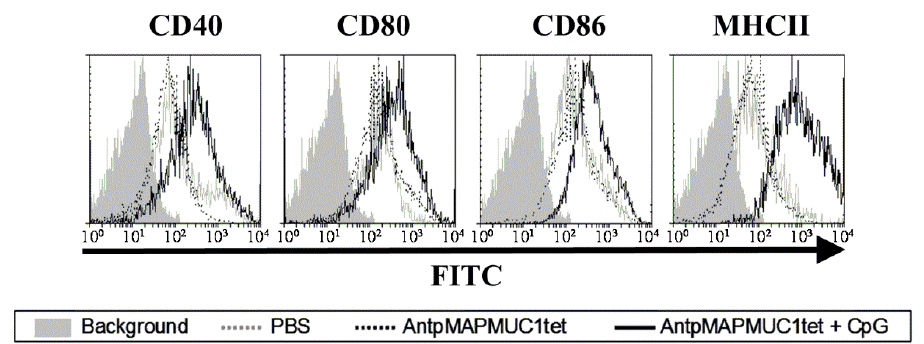
Figure 4. DC maturation in vivo by AntpMAPMUC1tet with and without CpG. C57BL/6 mice were injected i.d. with PBS, AntpMAPMUC1tet or AntpMAPMUC1tet + CpG. 18 h later popliteal lymph nodes were isolated and stained with the DC marker CD11c and maturation markers (CD40, CD80, CD86, and MHC class II) and assessed by flow cytometry. Representative histogram plots are shown ( n = 3).